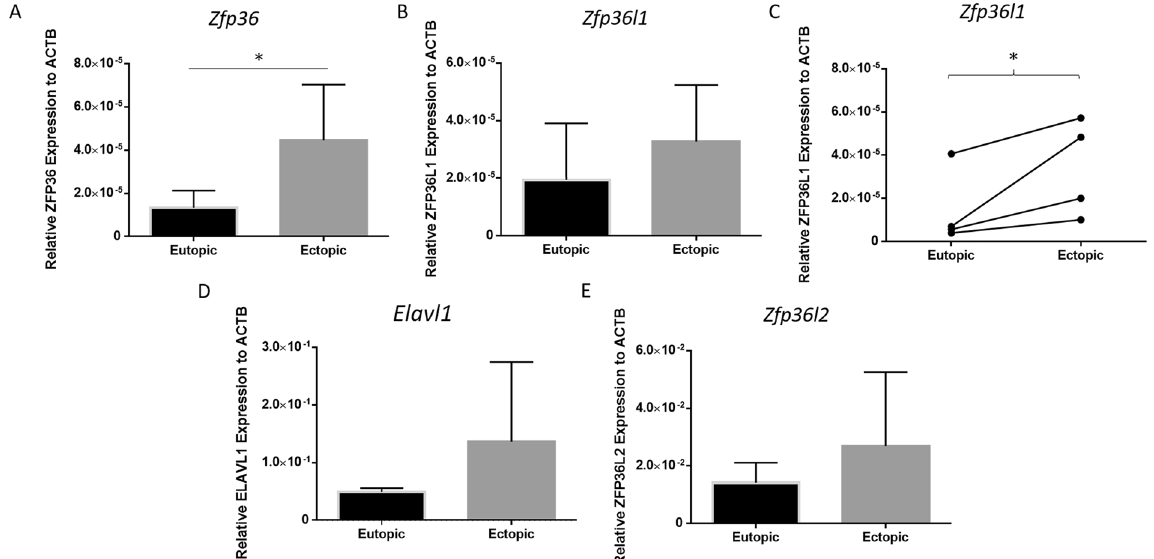
Figure 4. Upregulation of HuR/TTP axisRNA binding proteins Zfp36, Zfp36l1, Zfp36l2 (TTP family), and Elavl1 (HuR) mRNA in an in vivo mouse model of endometriosis. mRNA transcripts encoding for TTP ( Zfp36 ) is elevated in ectopic compared to eutopic endometrium obtained from Balb/c mice (panel A). Zfp36L1 was elevated in ectopic compared to eutopic endometrium using matched t-test (panel C), however did not significantly differ by unpaired student’s t-test (panel B). mRNA expression for Elavl1 and Zfp36l2 was not statistically significant (Panel D,E; p = 0.09), and did not differ by paired/matching tests. Endometriosis was induced in BALB/cByJ mice by surgical implantation of endometrium isolated from donor mice (n = 2) into the left peritoneal cavity of recipient mice. Data presented consists of Days 7 (n = 3) and 17 (n = 3) of eutopic endometrium and ectopic lesion harvest. Expression patterns did not change by collection day, however data is presented as both time points pooled n = 6. Expression data illustrated as mean ± SEM. * P < 0.05.